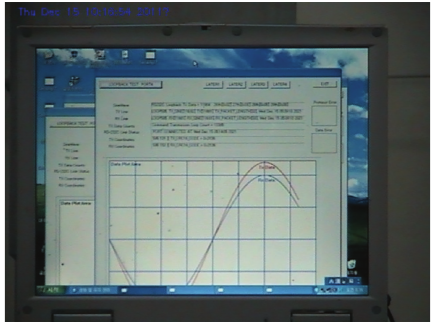
Figure 4: Menu image of the pilot application program, executed on a notebook PC under test (before gamma ray irradiation).